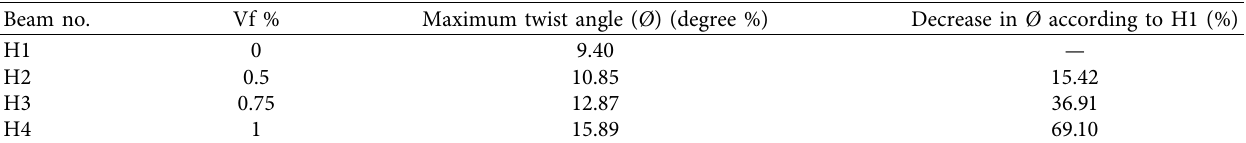
Figure 11: The twist angle and torque relationship. Table 10: The effect of fiber ratio on the twist